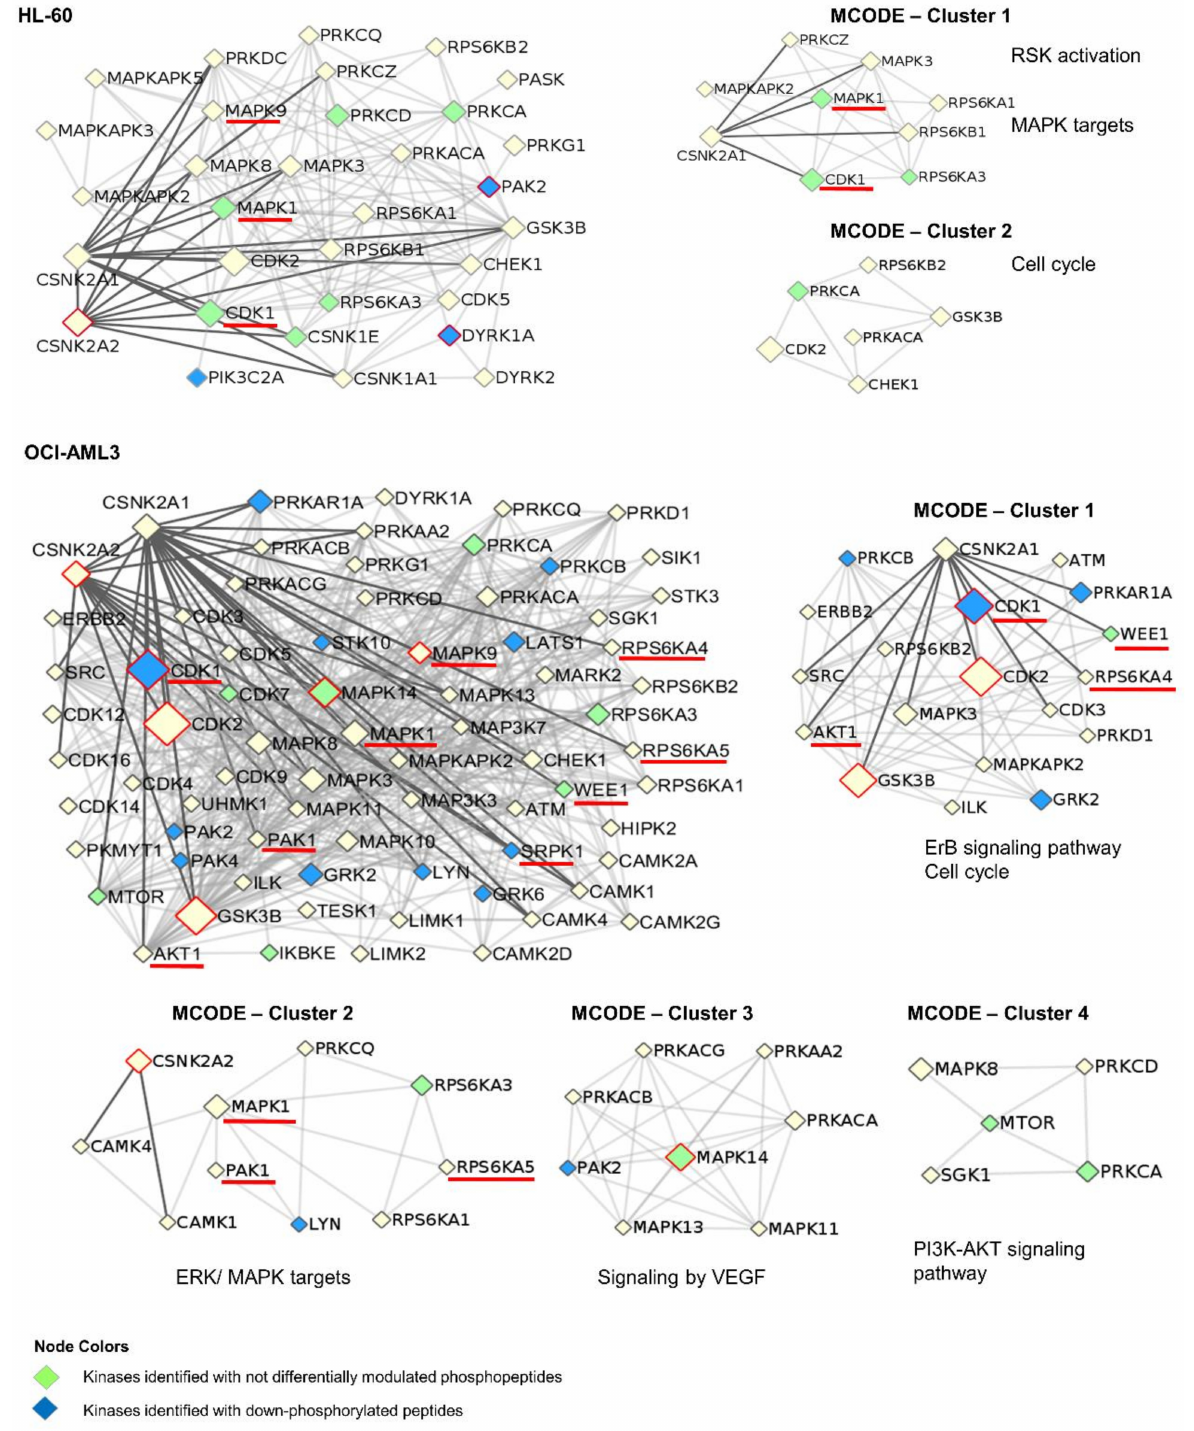
Figure 5. Protein-protein interaction network of kinases associated to phosphoproteomic profiles differentially modulated by CX-4945 in HL-60 and OCI-AML3 cells. Protein clusters were identified with MCODE algorithm and the related biological processes and signaling pathways are indicated. For each protein kinase the node size is proportional to the number of target phosphopeptides that appeared differentially phosphorylated in response to CK2 inhibition. Kinases that are significantly associated with the phosphoproteomic profiles, according to KEA2 results, are highlighted with a red border. In addition, kinases indicated with a red line are bona fide CK2 substrates, whereas green and blue nodes correspond to those kinases that were identified in our analysis with either not differentially modulated phosphopeptides and down-phosphorylated peptides,